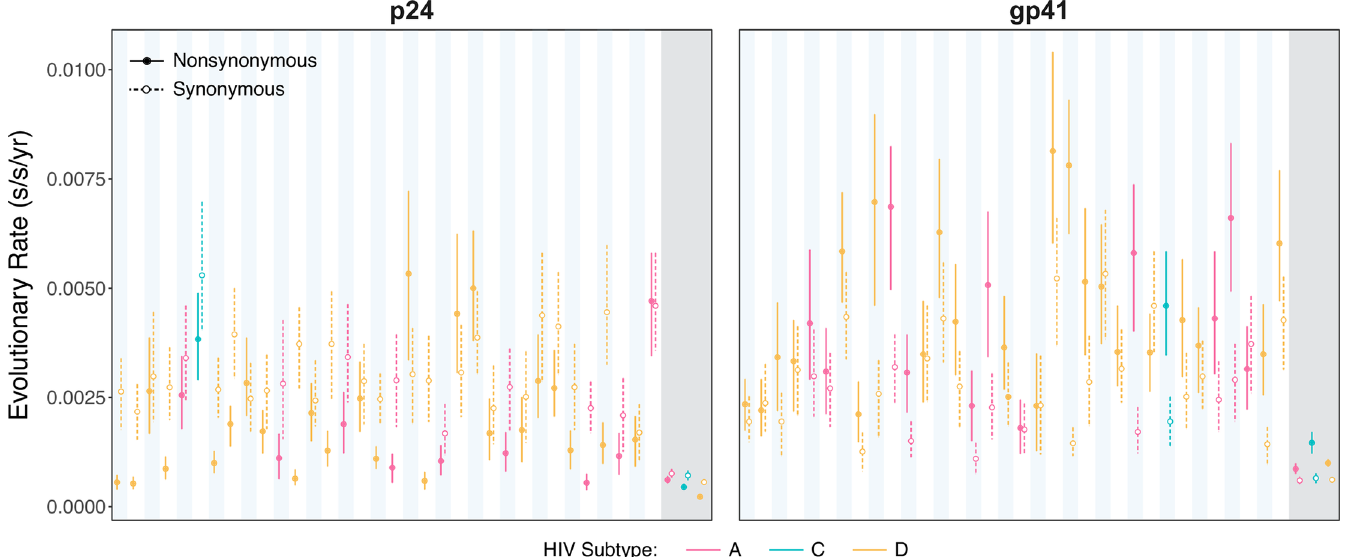
Fig 2. Evolutionary rates for p24 and gp41 at the within- and between-hosts scales measured in substitutions per site per year (subs/site/year). The within-host nonsynonymous (filled circles) and synonymous (open circles) substitution rates were estimated for p24 and gp41 for all 34 individuals, which are ordered from left to right (subtype A, pink; subtype C, green; subtype D, yellow). Blue and white columns correspond to the individual estimates. The estimates in the grey background indicate the between-host substitution rates for subtypes A, C, and D. The vertical lines represent the 95% credible intervals (solid lines, nonsynonymous; dashed lines,